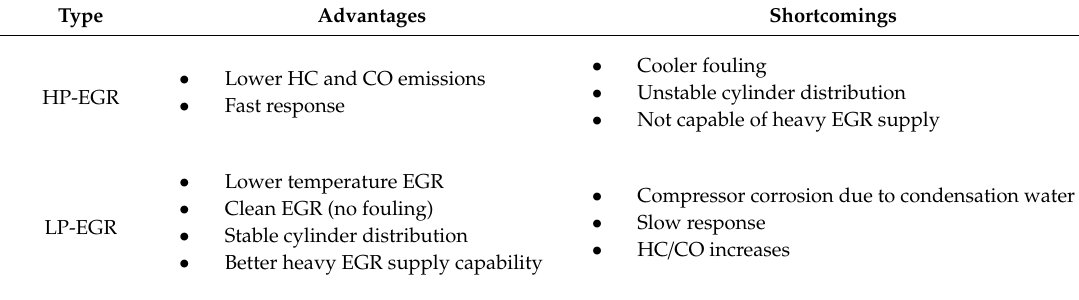
Table 1. Advantages and shortcomings of two types of